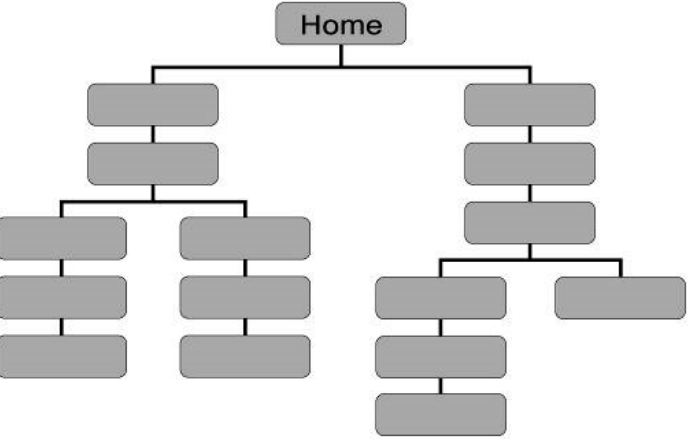
Figure 3. Overly deep information architecture makes it hard to find.